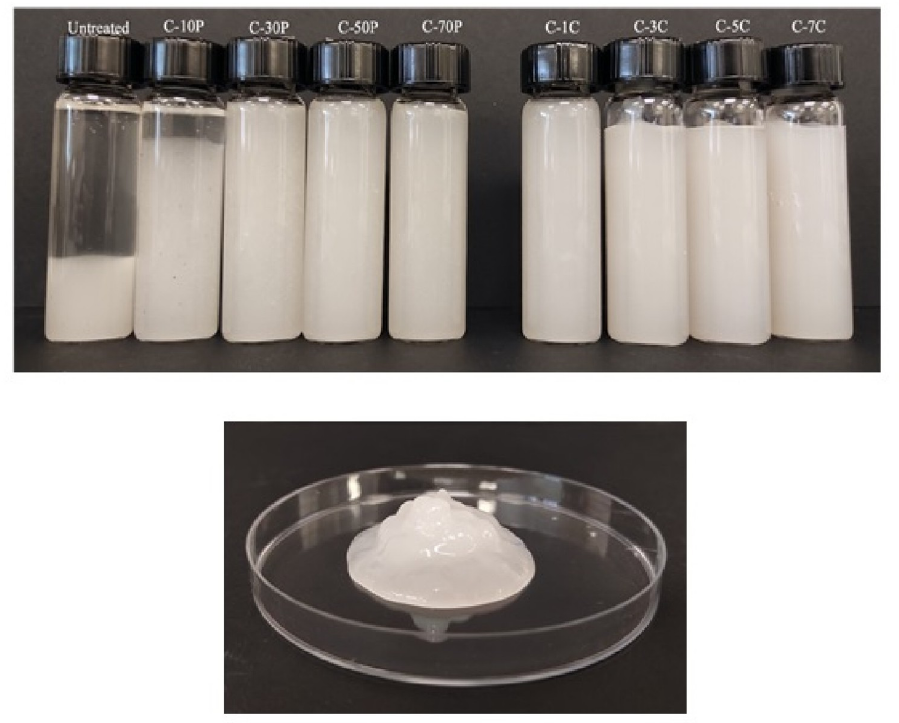
Fig 1. Pictures of (a) CNC suspensions subjected to different HPH treatments (C-10P to C-70P and C-1C to C-7C) and (b) gel-like structure of C-7C sample.From left to right, Untreated = Acid hydrolysed cellulose; C-10P = CNC treated at 10 MPa; C-30P = CNC treated at 30 MPa; C-50P = CNC treated at 50 MPa; C-70P = CNC treated at 70 MPa; C-1C = CNC treated for 1 cycle; C-3C = CNC treated for 3 cycles; C-5C = CNC treated for 5 cycles; C-7C = CNC treated for 7